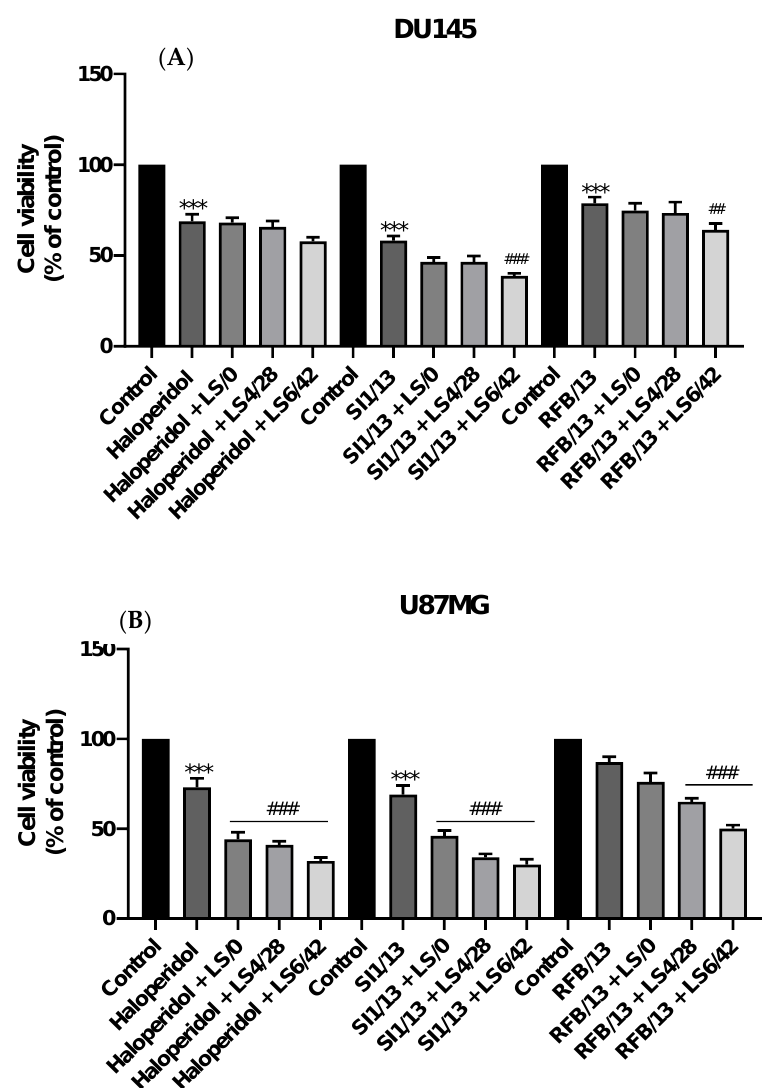
Figure 4. Effects of the combination of σ R ligands haloperidol, SI1/13 and RFB/13 and of HO-1 inhibitors LS/0 , LS4/28 and LS6/42 treatments on cell viability of DU145 (panel A ) and U87MG (panel B ) cell lines, assessed by MTT at the doses of 10 µ M, and compared to the effect obtained with σ R ligands alone at the same dose. Results are representative of at least three independent experiments and values are expressed as percentage of control (% of control). Data represent means ± SEM. *** p < 0.001 vs. control, ## p < 0.001 and ### p < 0.001 vs. σ R ligand as determined by one-way ANOVA followed by Tukey’s multiple comparison